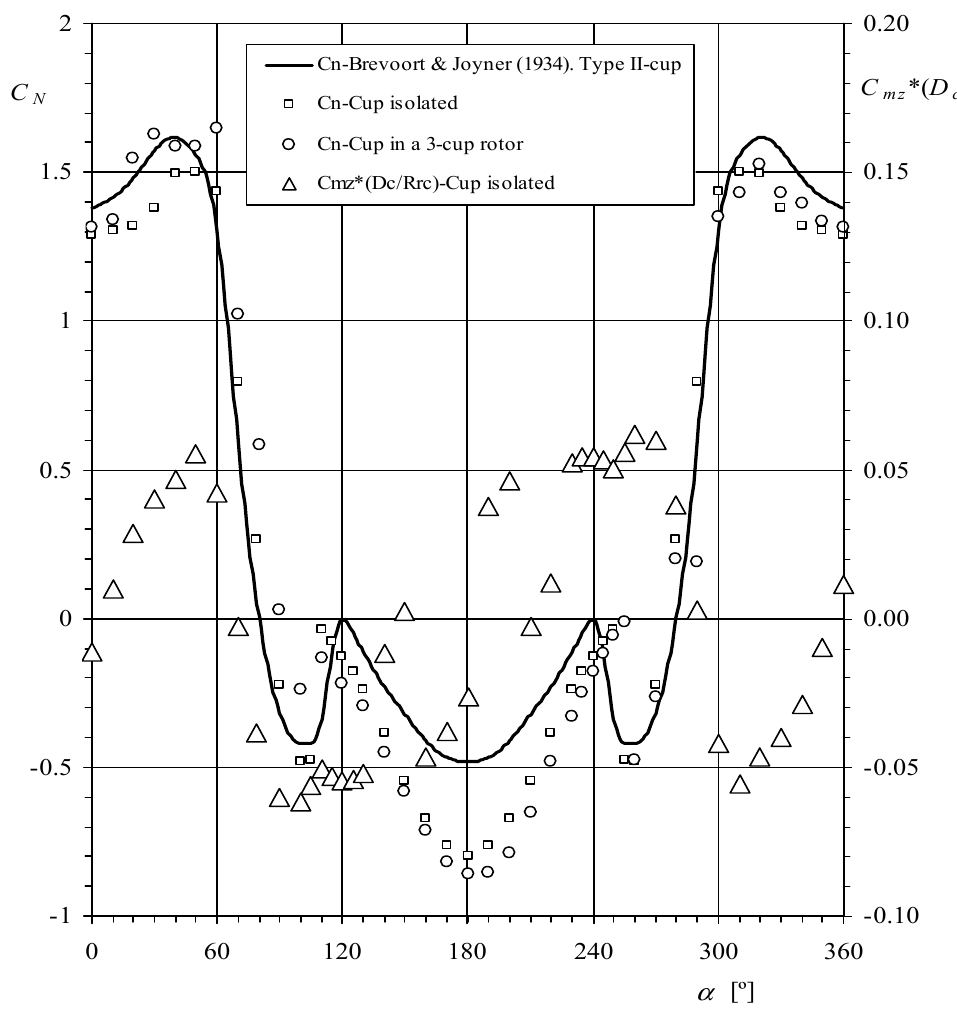
, measured on cup, isolated and Figure 13. Normal aerodynamic force coefficient, c N surrounded by the other two simulating an anemometer’s rotor as a function of the wind direction with respect to the cup, α . The aerodynamic yawing moment coefficient, c / R ( D = 50 mm and R = 60 mm were selected to calculate this multiplied by the ratio D c rc c rc ratio as normal values from commercial anemometers), has been also included in the